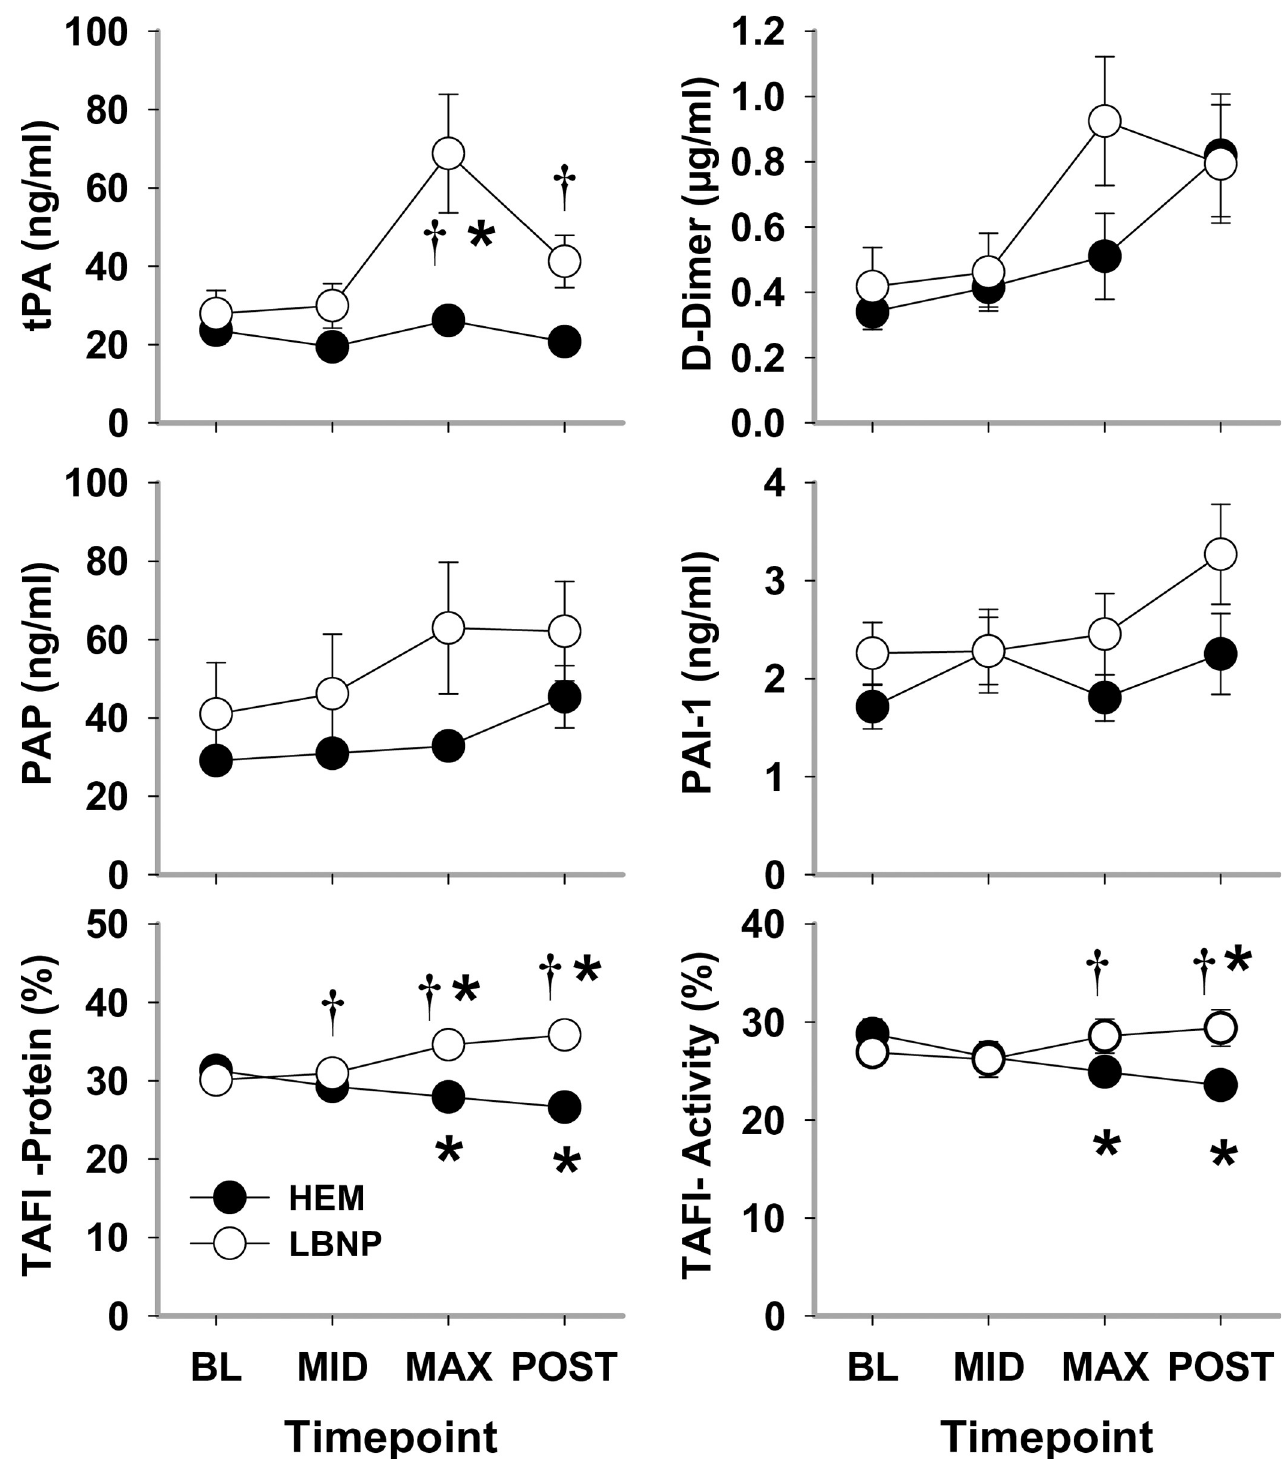
Fig 6. Fibrinolysis indicators tissue-type plasminogen activator (tPA), D-dimer, plasmin- α 2 -antiplasmin complex (PAP), plasminogen activator inhibitor (PAI-1), thrombin activatable fibrinolysis inhibitor (TAFI) protein and activity during HEM and LBNP in anesthetized baboons. Mean ± SE, n = 12–13; � different from baseline ( P < 0.05); and † different from blood removal ( P < 0.05).